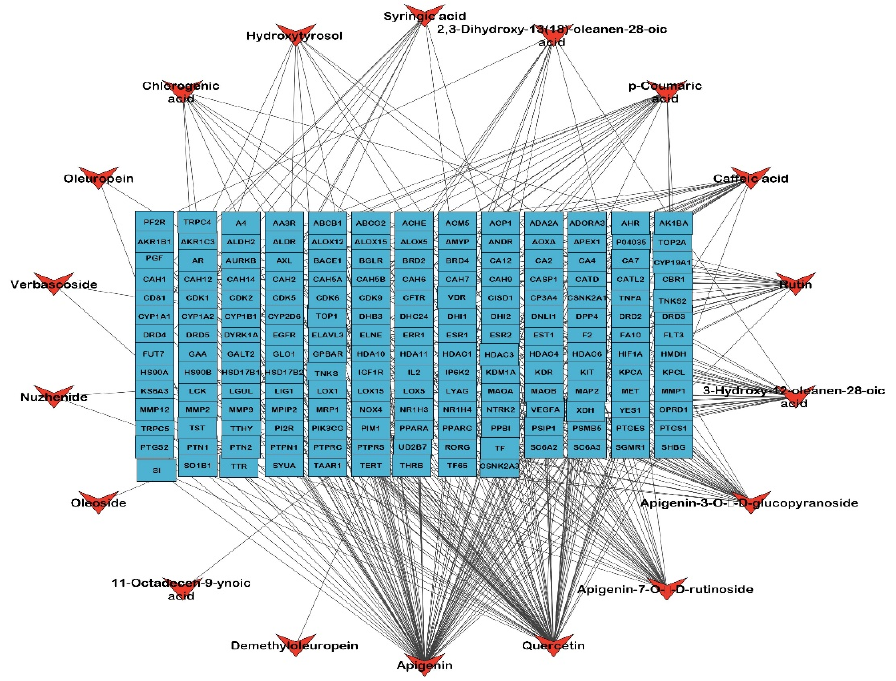
Figure 3. The compound–target gene network shows the interaction and correlation between identified compounds of Olea europaea L. cv. Picual and target genes. Blue rectangles represent the target gene names; orange arrowheads represent the identified compounds.